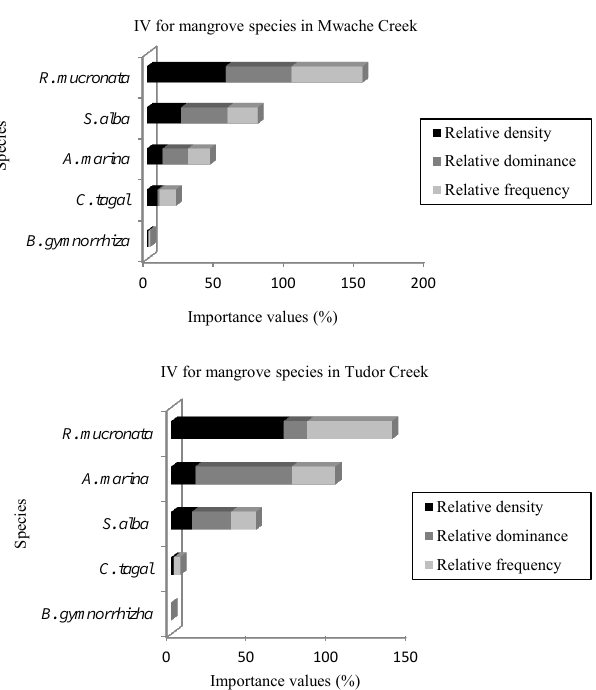
Table 3. Classification accuracy for the 2009 image based on the different classes delineated.